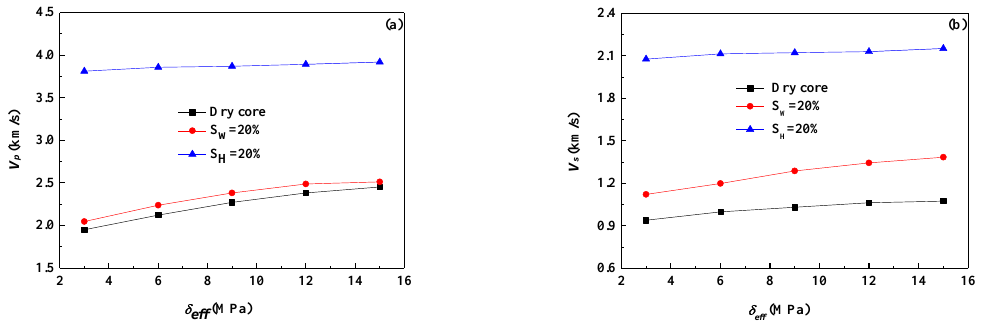
Figure 4. The relationship between acoustic velocities, P-wave velocity ( a ) and S-wave velocity ( b ), Figure 4 The relationship between acoustic velocities, P-wave velocity (a) and S-wave velocity (b), and e ff ective confining pressure, pore occupants for core and effective confining pressure, pore occupants for core S1.